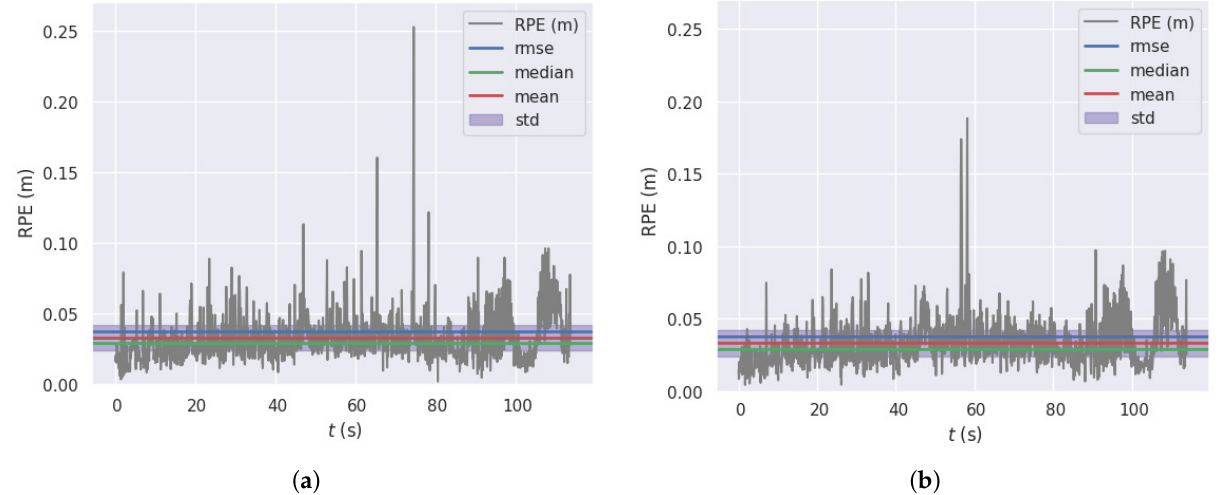
Figure 5. KITTI 01 dataset RPE with regard to translation part(m) for delta = 1 (frames) using consecutive pairs (with Sim(3) Umeyama alignment, while processing panning rotation and scale): ( a ) delete all dynamic points; ( b )